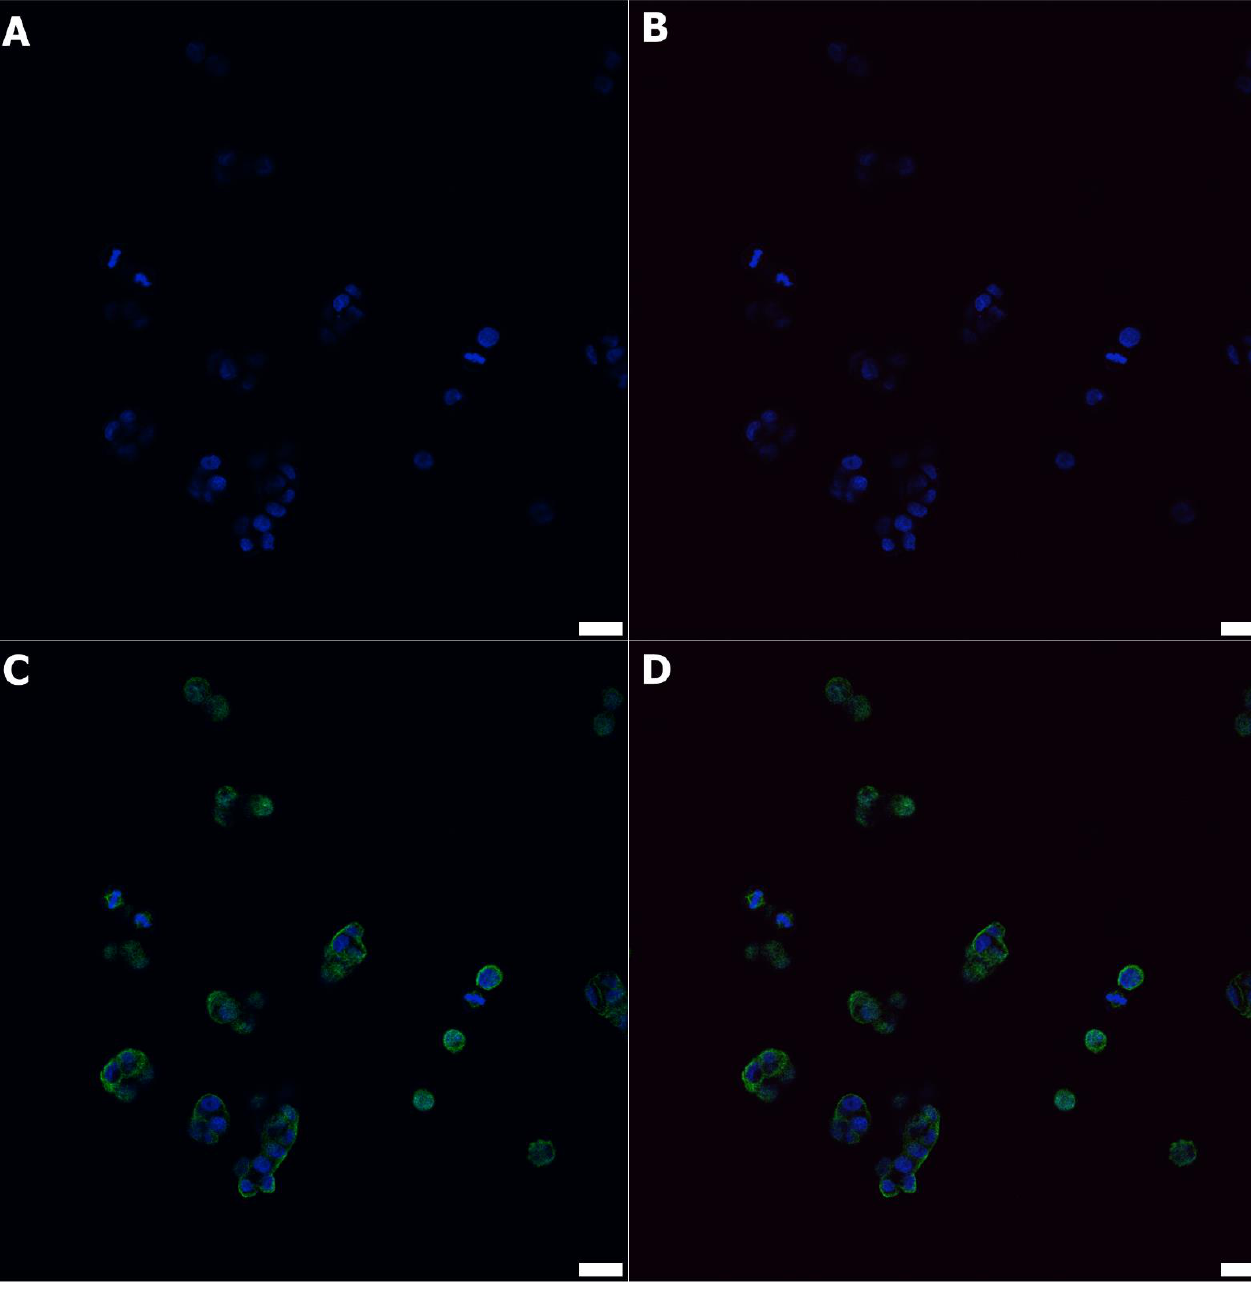
Figure 1. The immunofluorescence labeling against nuclei (blue DAPI), HIF1 α (red), and β -actin (green) in normoxic HT-29 cells ( A – D ) showed no HIF1 α -positive cells ( B , D ). All cells were positive on DAPI ( A – D ) and β -actin ( C , D ); scale bars = 20 μ m.